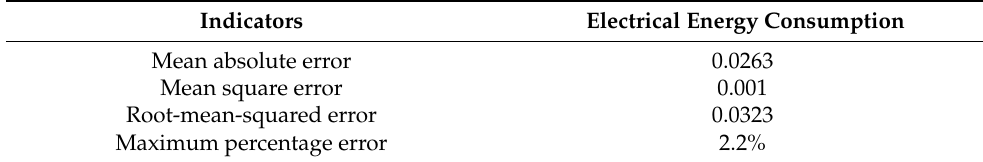
Figure 13. Representation of the variation over time of the absolute error and relative error of electrical energy consumption. Table 7. Calculation of electrical energy consumption error.